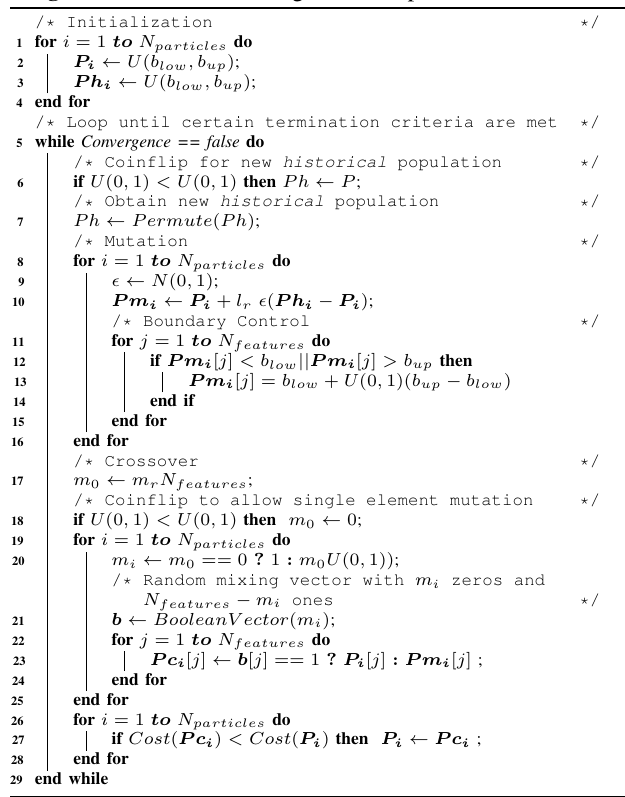
Algorithm 2: Backtracking Search